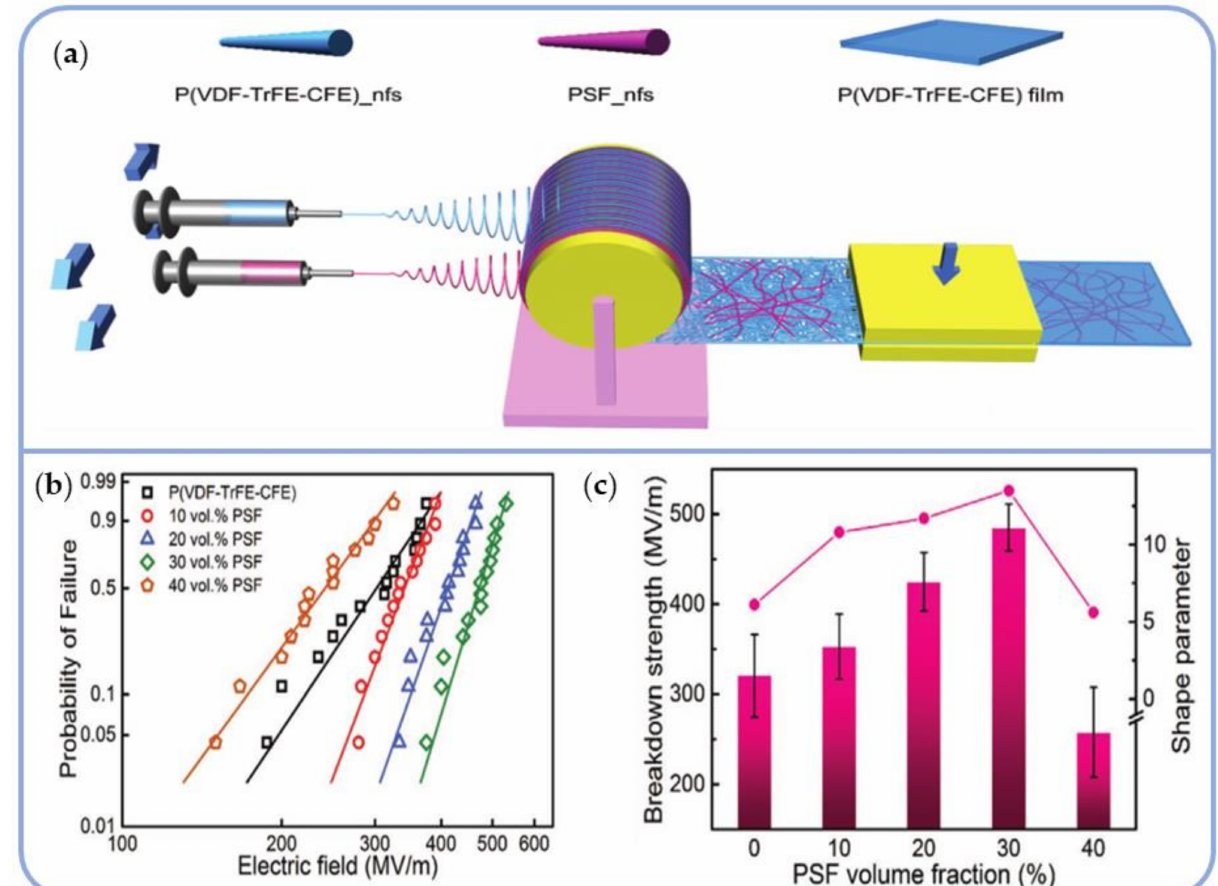
Figure 13. ( a ) Schematic diagram of the composite film prepared by combinatorial-electrospinning and hot-pressing; ( b ) The Weibull distribution for P(VDF-TrFE-CFE)/PSF with various PSF contents; ( c ) The Weibull breakdown strength and shape parameter β as functions of PSF volume fractions. Reprinted with permission from [132]. Copyright (2019),